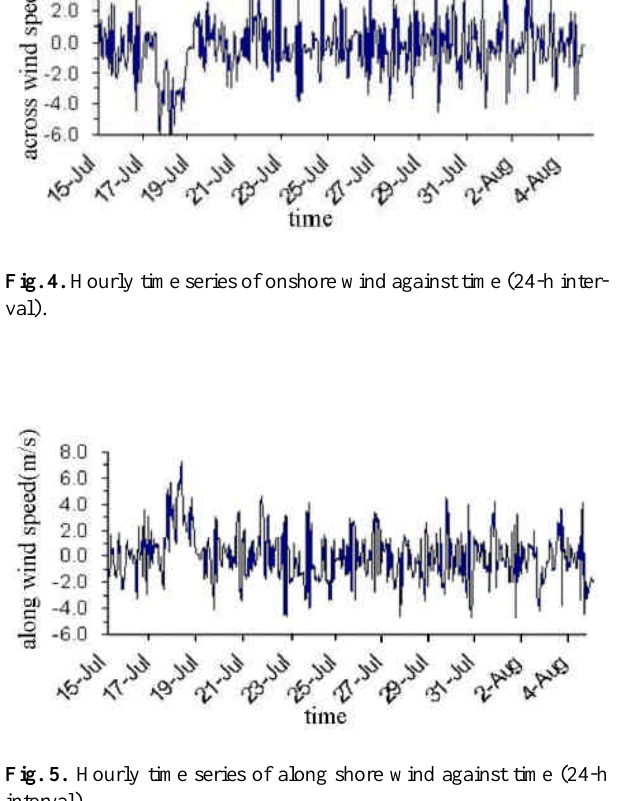
Figure3. Hourly time series of wind speed (U 10 ) against time (24h interval)